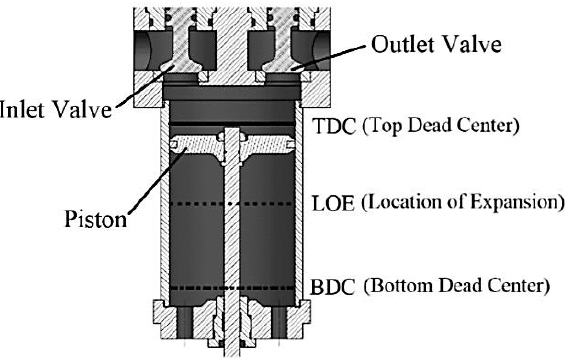
Figure 17. Two-phase free piston expander, showing the principle of operation [ Error! Reference source not found. ].